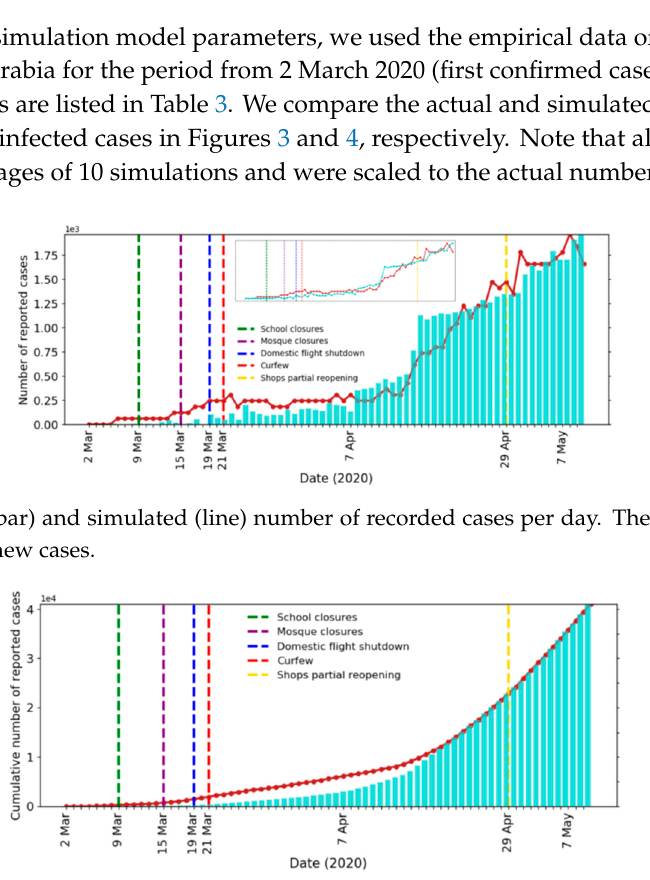
Figure 4. Actual (bar) and simulated (line) cumulative number of recorded cases per day.